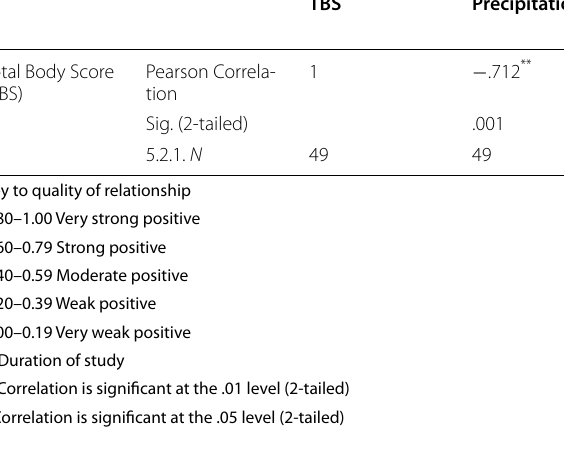
Table 5 Relationship between decomposition rate (TBS) and factors that affect decomposition